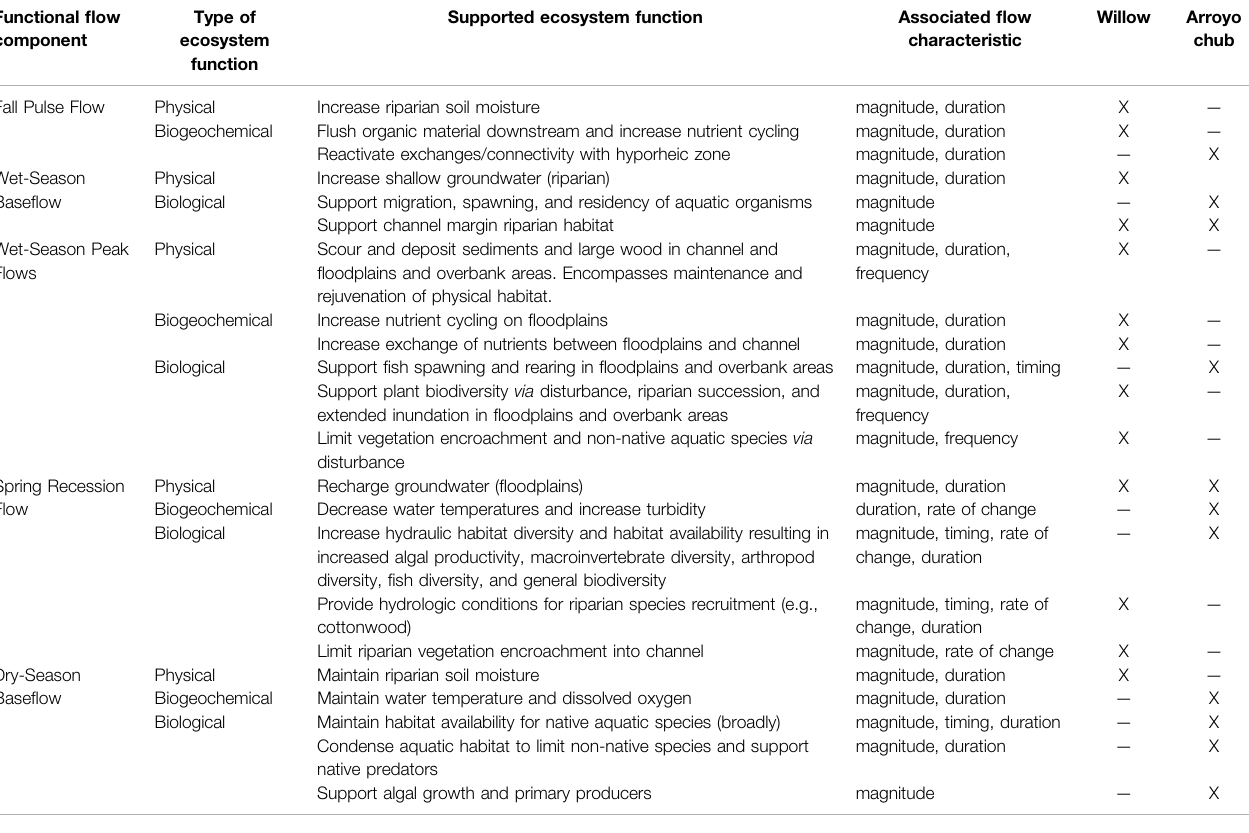
TABLE 3 | Functions associated with functional fl ow components and species of management concern, willow and arroyo chub. Table adapted from (Yarnell et al., 2020). Functional fl ow component